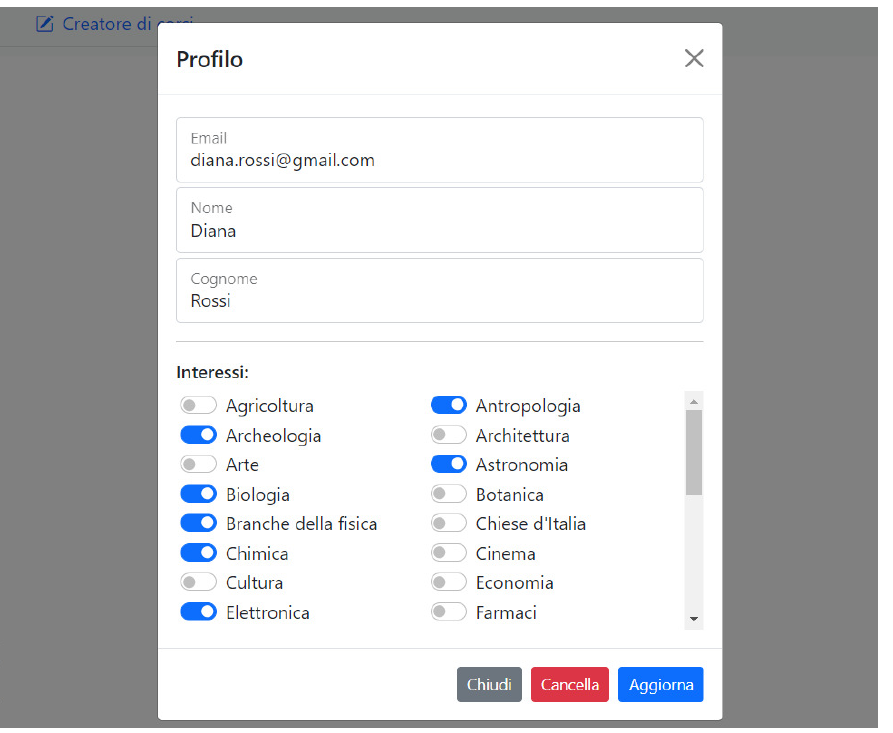
Figure 6. The W IKI TEL’s graphical interface allows users to specify their own topics of interest. The user of the figure, in particular, is interested in anthropology, archeology, astronomy,